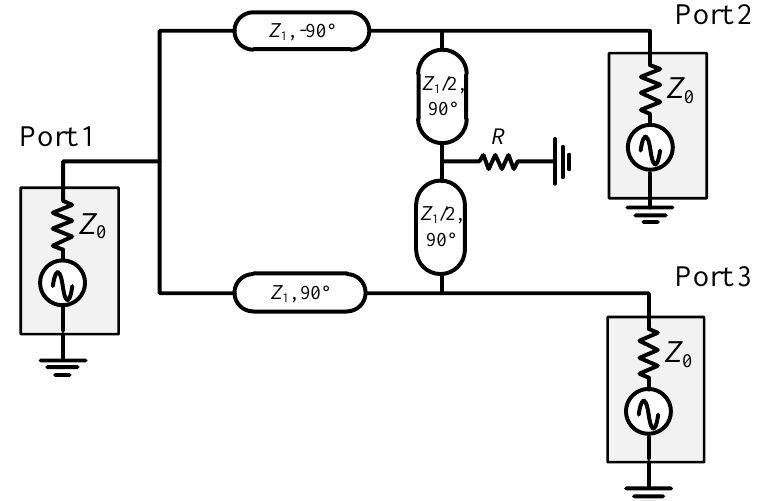
Figure 1. Schematic of the conventional Wilkinson − type balun.